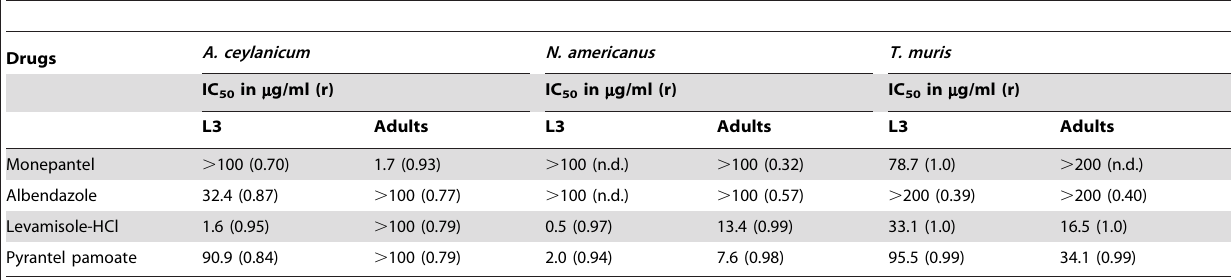
Table 1. 50% inhibitory concentrations of monepantel, albendazole, levamisole, and pyrantel pamoate on A. ceylanicum , N. americanus , and T. muris